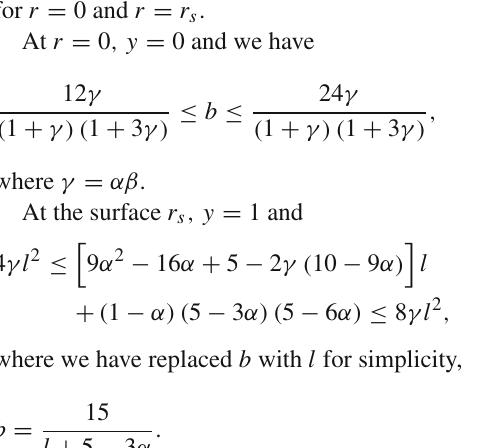
M sol = 1 . 988 × 10 33 g, so that GM sol / c 2 = 1 . 474